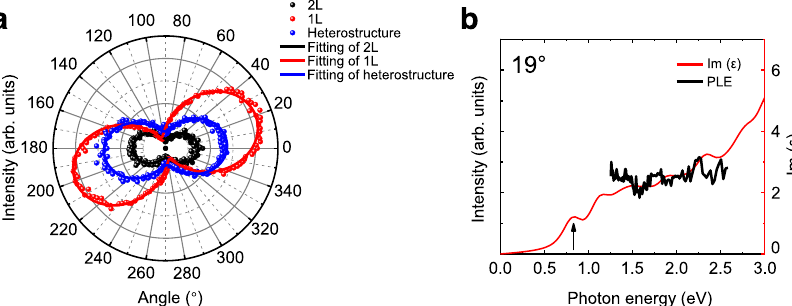
Fig. 3 Optical properties of the 19° twisted phosphorene heterostructure. a Polarization-dependent PL emissions (dots) and the corresponding fi tting curves (solid lines) of the monolayer (red), bilayer (black), and the twisted phosphorene heterostructure (blue). The heterostructure shows a linearly polarized emission, and its principal axis is rotated by 4° from the bilayer polarization principal axis. b Comparison between the PLE spectra (black solid line) and the calculated imaginary parts of dielectric functions (red line) of the 19° twisted phosphorene heterostructure. The black arrow indicates the PL emission energy for the 19° twisted